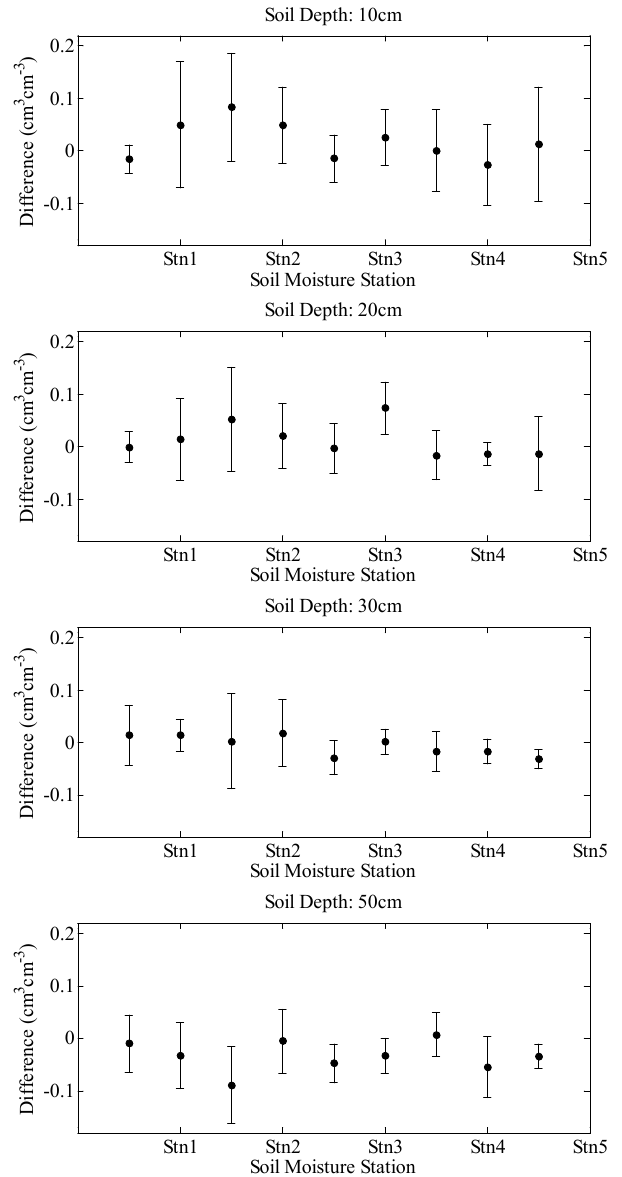
Fig. 5. Mean difference between Campbell Scientific CS616 TDR and Stevens Water Hydra Probe hourly soil moisture values at K1 from 2007 to 2011. The error bars represent one standard